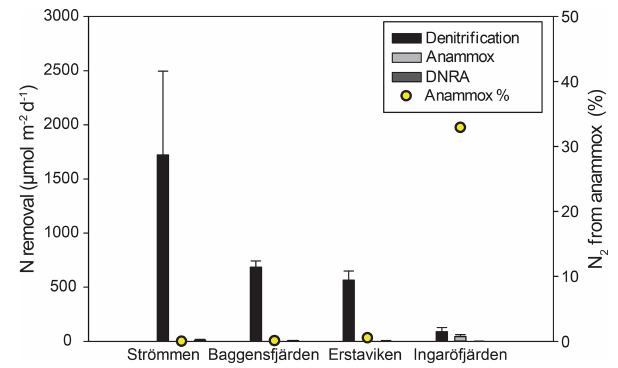
Figure 7. Bar diagram showing the areal rates of benthic NO − reducing processes, including error bars. Relative contribution of anammox is indicated by the yellow